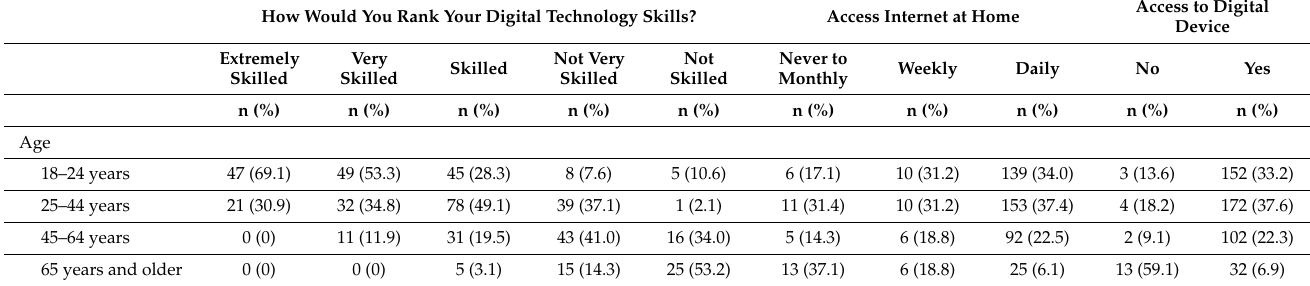
Table 3. Cross-tabulations by age and digital technology skills and